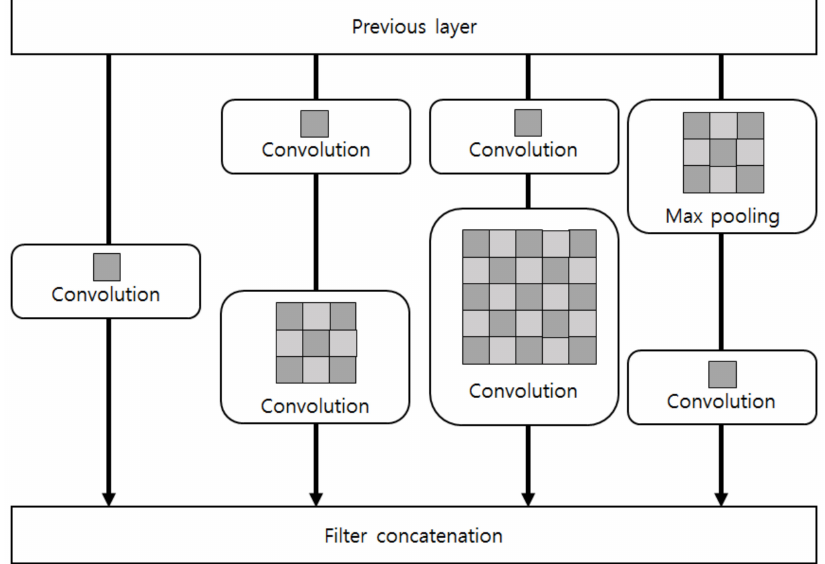
Figure 2. Structure of inception